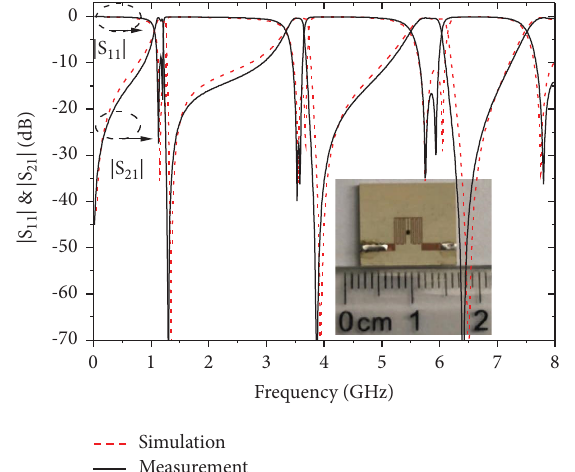
Figure 6: Simulated and measured results of tri-band BPF.